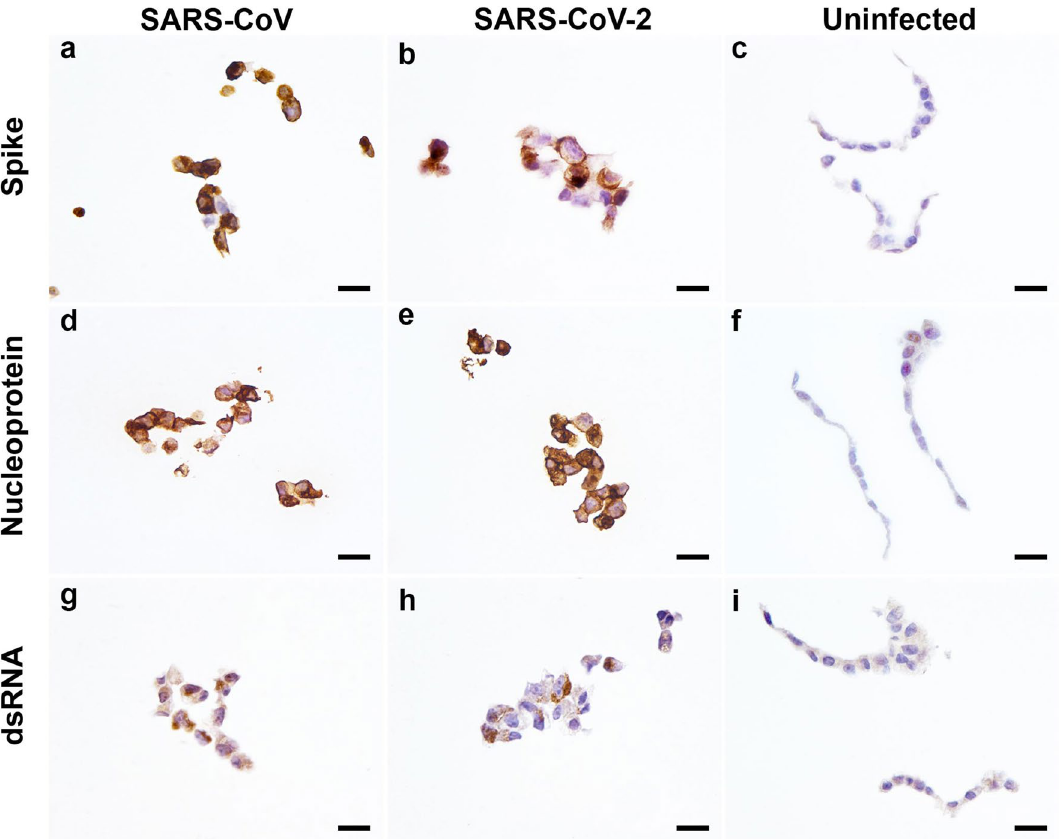
nucleoprotein rabbit polyclonal antibody (d–f) and double-stranded RNA (dsRNA) rabbit monoclonal antibody (g–i) . Scale bars, 20